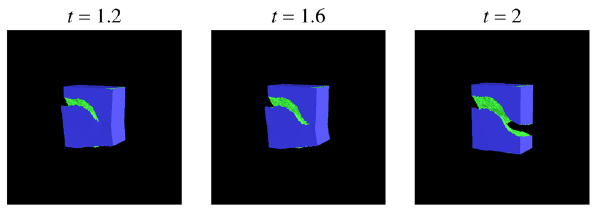
Fig. 12 (mode I+III) An initial slanted crack grows in a thick plate with given boundary displacement at the top and bottom of the plate ( g = ± t ( 0,0.5,0 ) , ϵ = 0.01, γ ∗ = 0.5